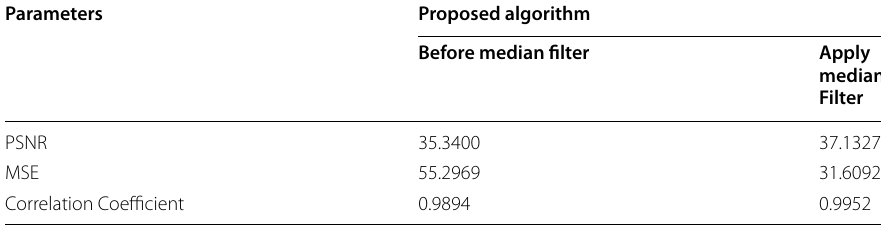
Table 8 Speckle noise